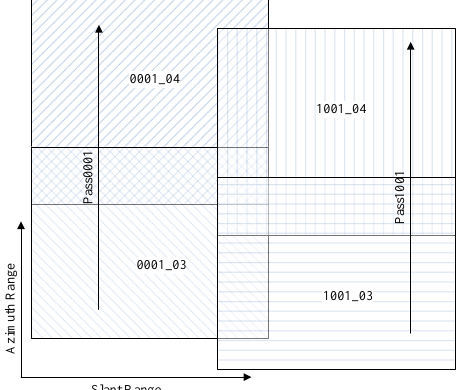
Fig.7 Relationship between the selected blocks The intensity images of selected blocks are shown in Fig.8. In order to calibration, the GCPs were selected according to the features in images, and their coordinates were measured by differential GPS. The GCPs’ distributions for two blocks in pass 0001 were Data 0001_04 and Data 0001_03. The GCPs’ distributions for blocks in pass 1001 were Data 1001_04 and Data 1001_03. The heights of GCPs are list in Tab.2.